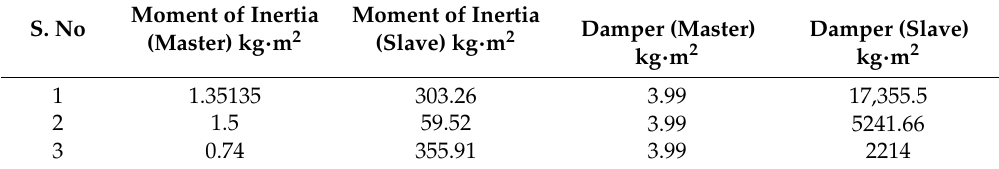
Table 2 . Hydraulic servo system dynamics parameters. Table 2. Hydraulic servo system dynamics parameters.